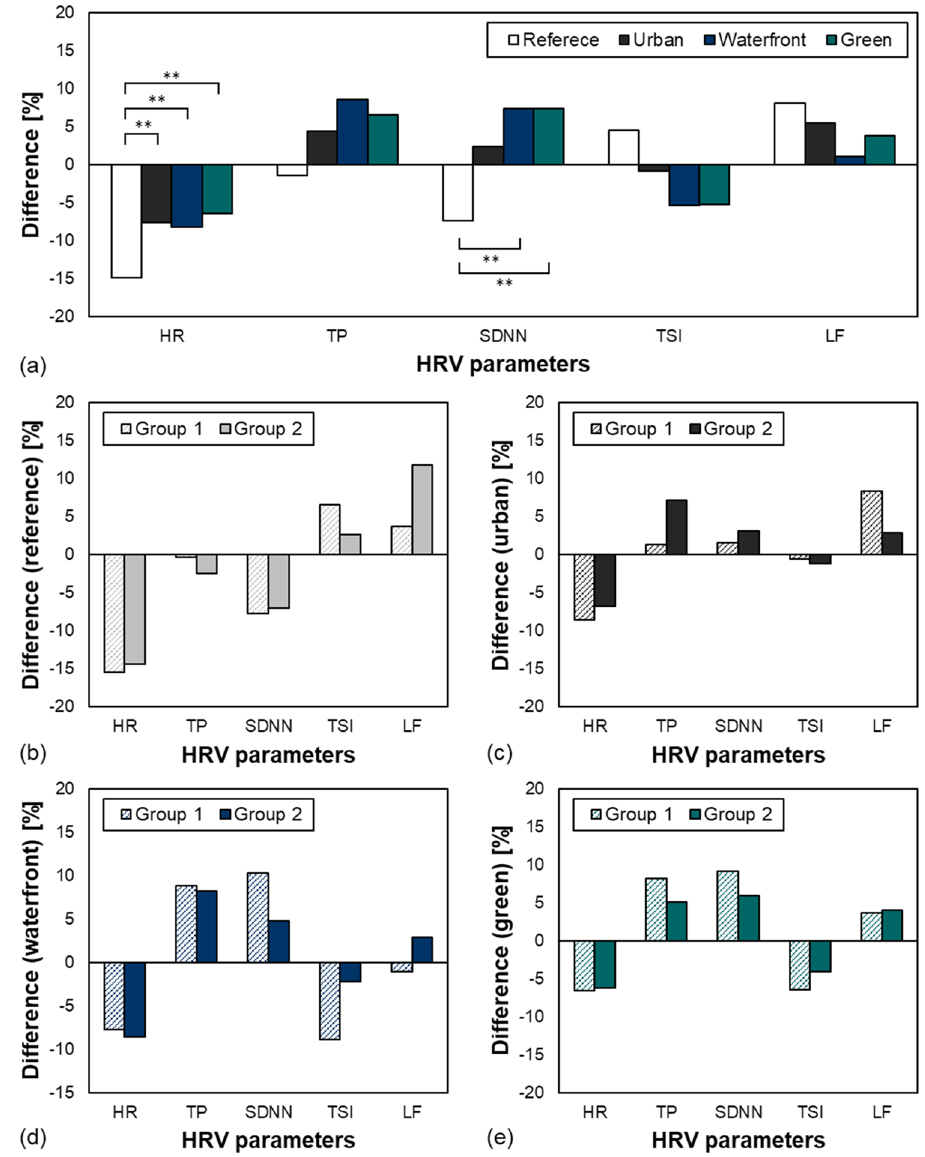
Figure 5. Differences in the heart rate variability (HRV) before and during audio-visual stimuli experience. ( a ) HRV difference according to space function, ( b ) HRV difference in reference with different groups, ( c ) HRV difference in urban with different groups, ( d ) HRV difference in waterfront with different groups, ( e ) HRV difference in green with different groups. Heart Rate (HR), Total Power (TP), Standard Deviation of Normal to Normal (SDNN), Temporary Stationary Index (TSI), Low Frequency (LF; ** P -value <